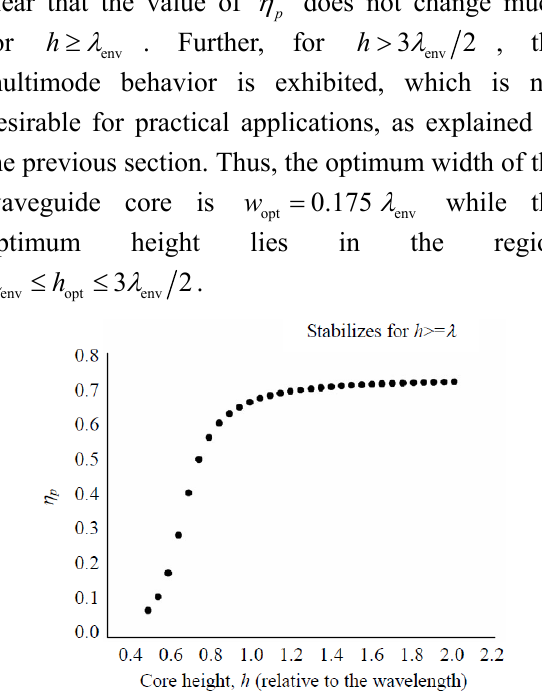
Fig. 4 Values of the parameter  height h in the case of